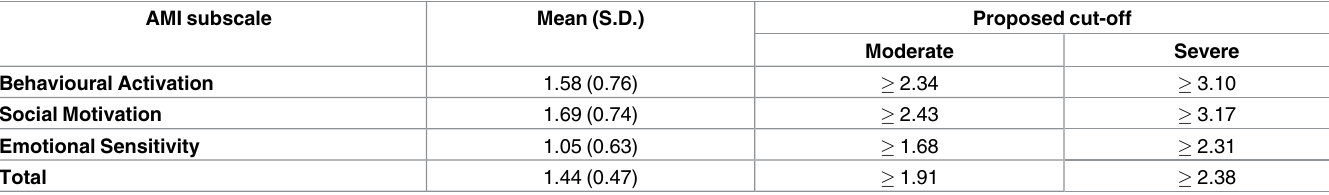
Table 4. Proposed cut-offs for moderate ( > 1S.D.) and severe( > 2S.D.) apathy on AMI. AMI subscale Mean